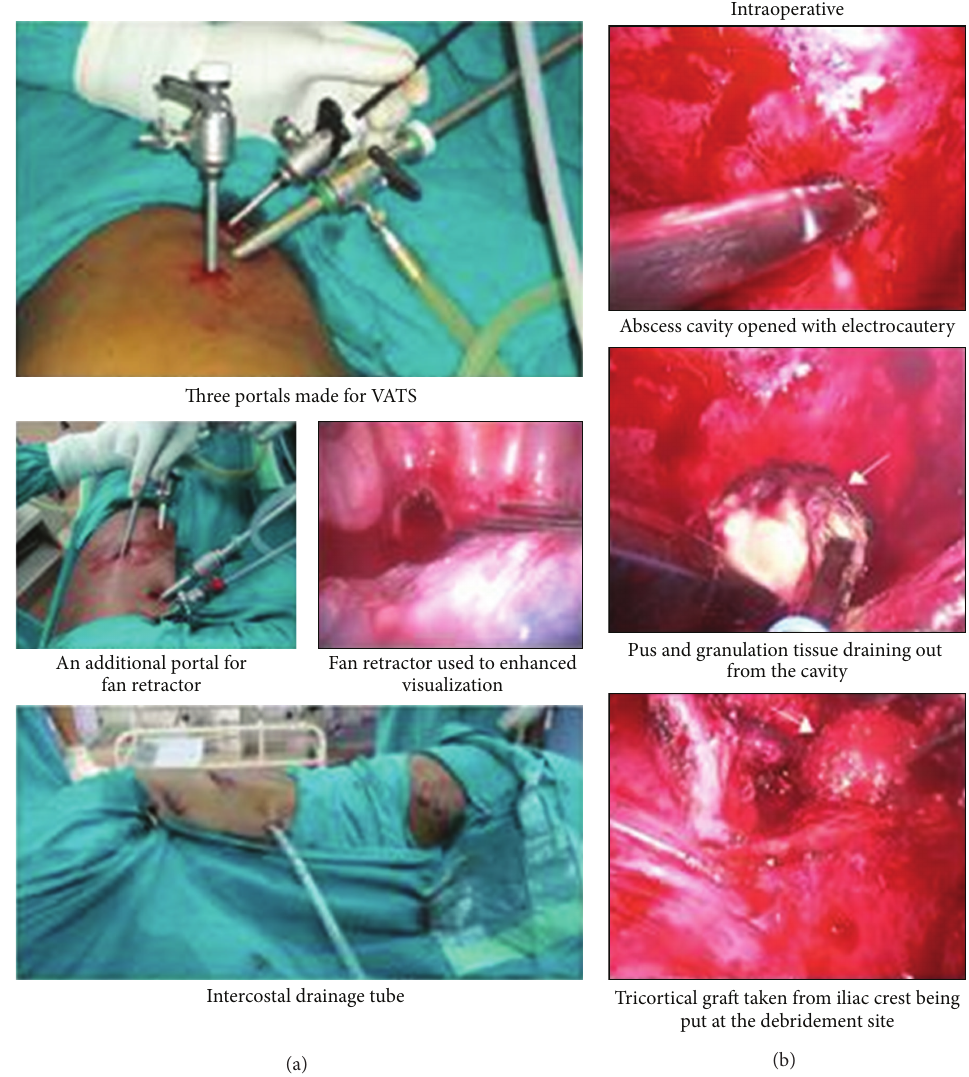
Figure 1: Peroperative and postoperative photographs of the VATS. (a) Portal placements and intraoperative and postoperative chest tube drainage. (b) Peroperative photographs showing opening of the lesion and debridement. Tricortical graft was put after